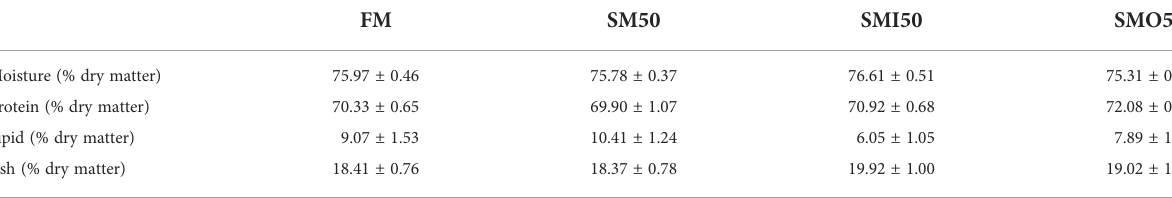
FM (45% crude protein and 12% crude lipid); SM50, by replacing 50% of FM with SM, SMI50, by replacing 50% ofFM with SM and inulin addition; SMO50, by replacing 50% of FM with SM and oligofructose addition. Values are mean of triplicate groups and presented as mean ± SEM. The lack of superscript letter indicates no signi fi cant differences (P > 0.05) among